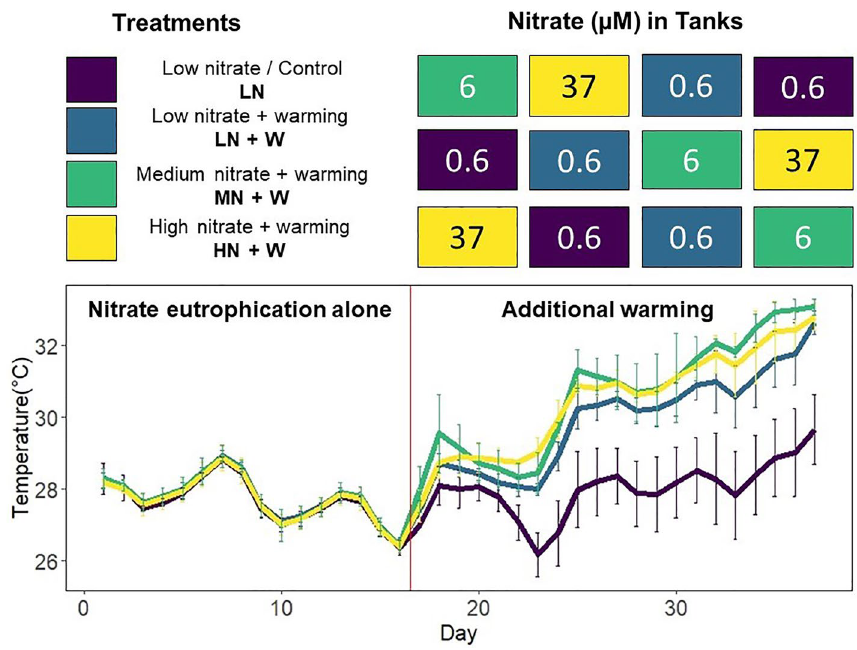
Figure 1. Experimental design with development of temperatures per treatment. Tanks were arranged in the depicted order vertically, with four tanks on every level. The experiment lasted 37 days, and temperatures were increased gradually from day 17 in all but the low nitrate (LN) control tanks. During the first 16 days of the experiment, both low nitrate treatments (LN and LN + W) were exposed to the same conditions. This changed as temperatures in the LN + W treatment increased together with the MN + W and HN + W